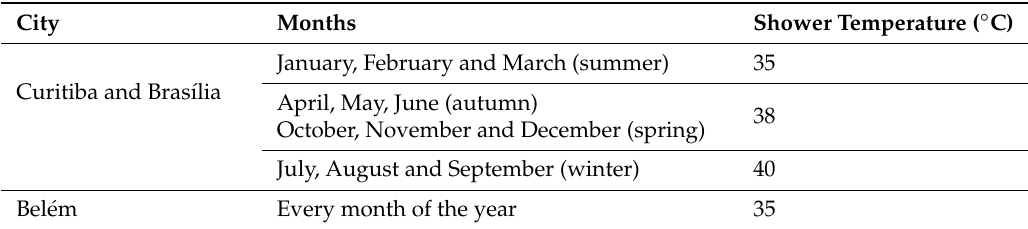
Table 3. Hot water temperatures along the year for the three